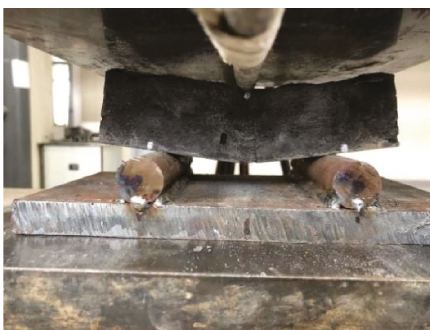
Figure 4: Appearance of the specimen with flexural failure resistance.